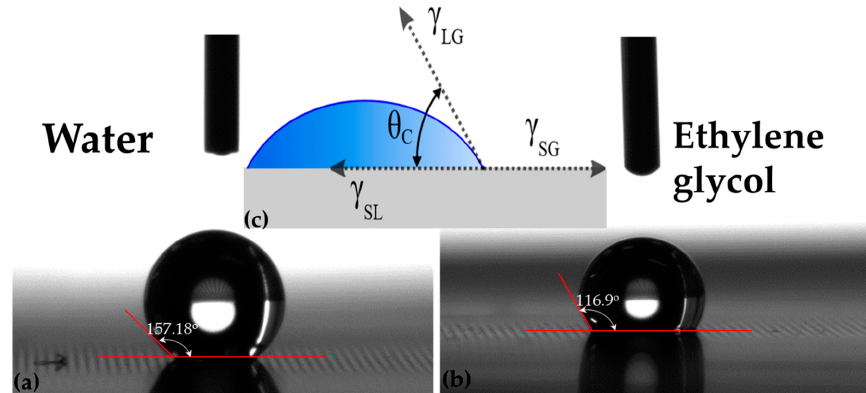
Figure 14. Digital images of contact between testing fluids and FeN thin film at room temperature. ( a ) Contact angle with water; ( b ) Contact angle with Ethylene glycol; and ( c ) Inset is a sketch of the sessile drop technique where θ C is the contact angle, and γ LG , γ SG , γ SL represent the liquid-gas, solid-gas, and solid-liquid interfaces, respectively.